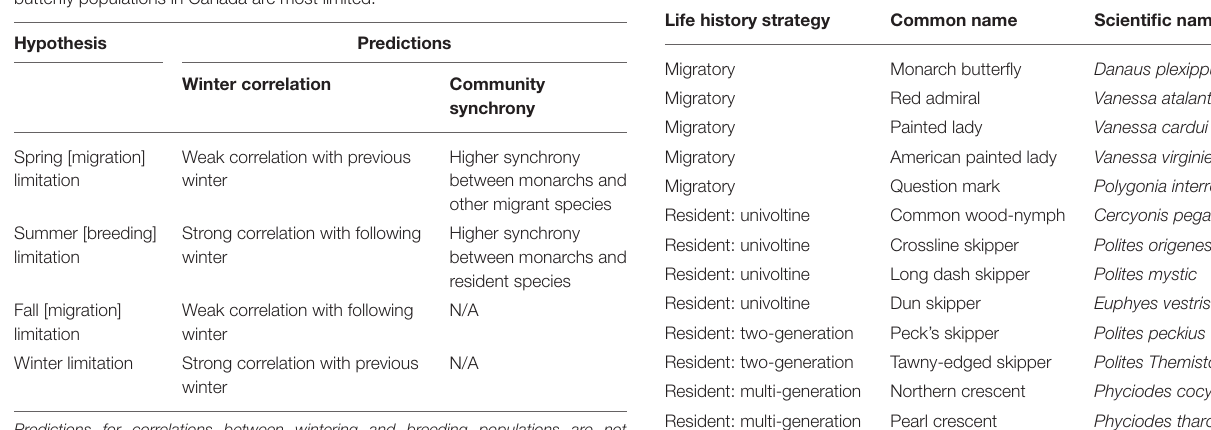
TABLE 2 | Species included in community level analyses of temporal